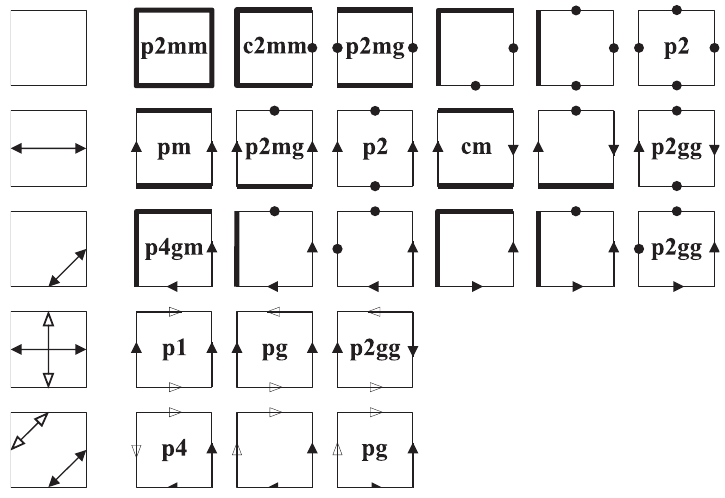
Figure 4. Edge pairings and edge identifications of the